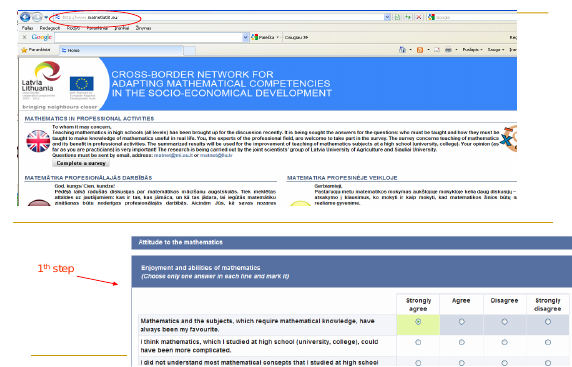
Figure 3. Organisational model underlying the curriculum (according to L.R.Mustoe and D.A. Lawson)